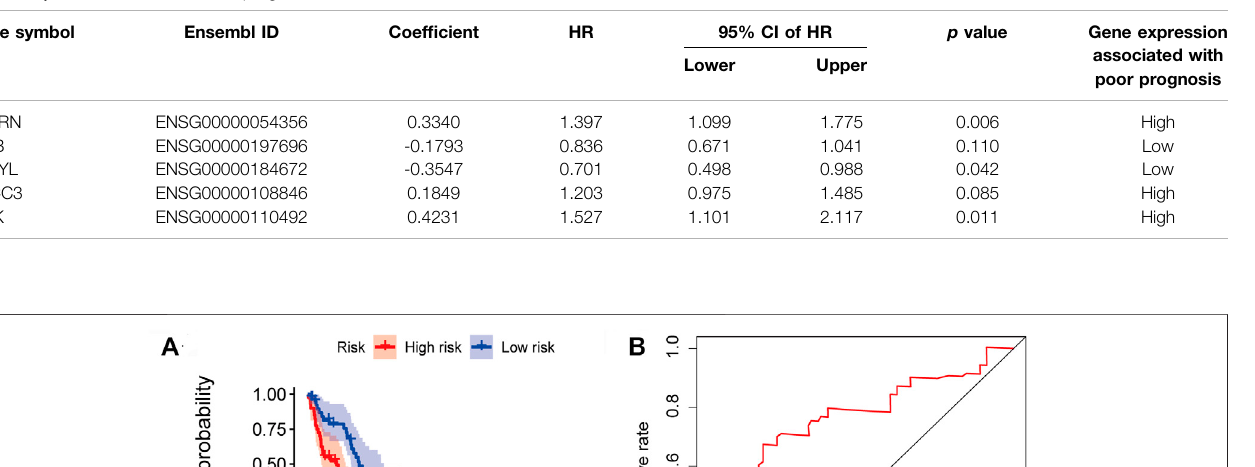
Frontiers in Genetics |